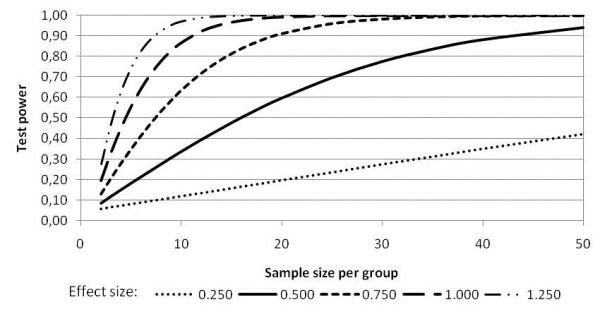
The power analysis.